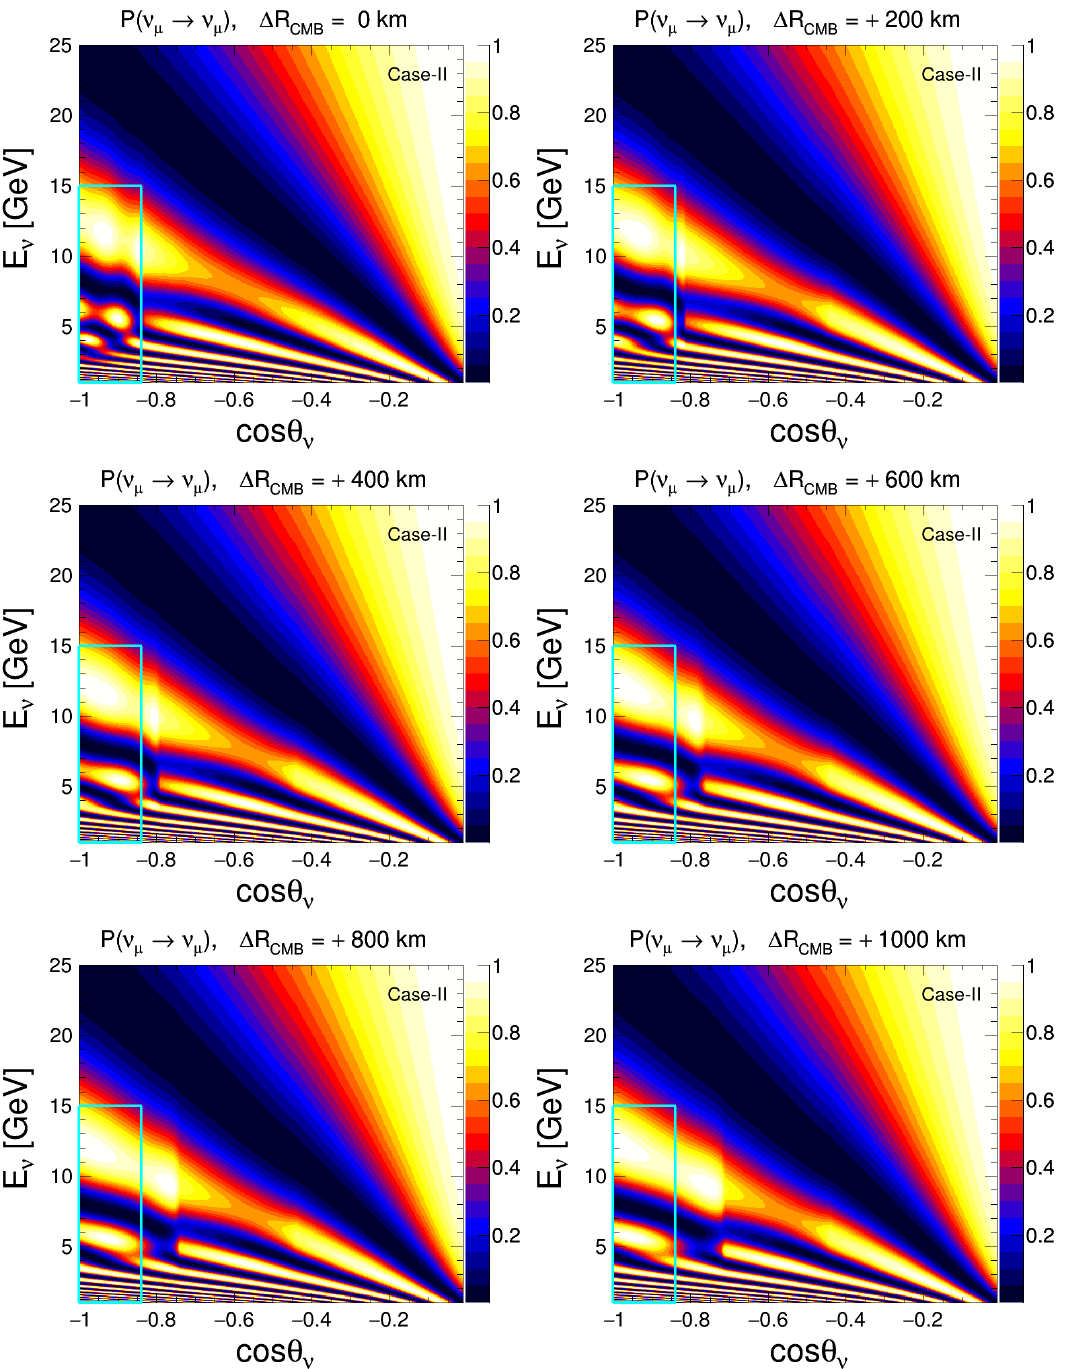
Figure 10 . Possible impact of larger core radii on three-flavor ν µ → ν µ oscillograms for the three-layered profile of Earth. The oscillograms are shown for R ∆ R = (0 , +200 , +400 , +600 , +800 , +1000) km, with the density profile modified according to CMB Case-II. We use three-flavor neutrino oscillation parameters given in table 2, where we assume NO and sin 2 θ = 23